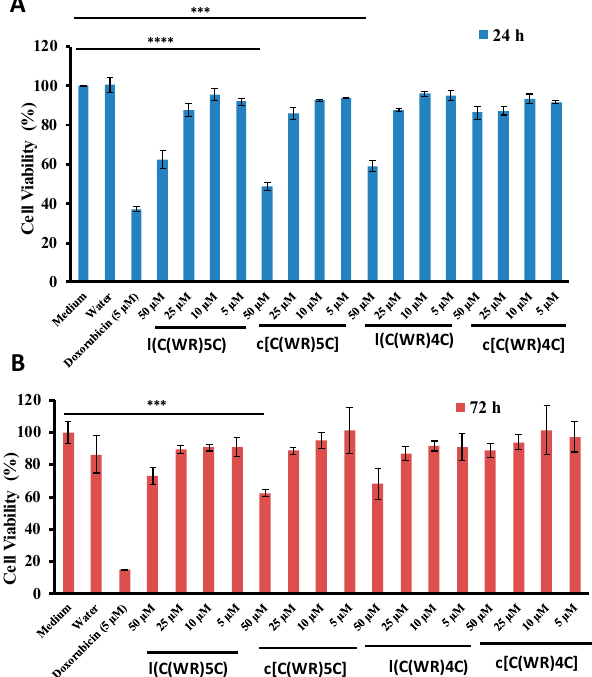
Figure 3. MTS assay of peptides (5–50 µM) on CCRF-CEM cell lines: ( A ) 24 h incubation and ( B ) 72 h incubation ( n = 3) (if p < 0.05 then *, if p < 0.01 then **, if p < 0.001 then ***, if p < 0.0001 then ****). Error bars are SD.